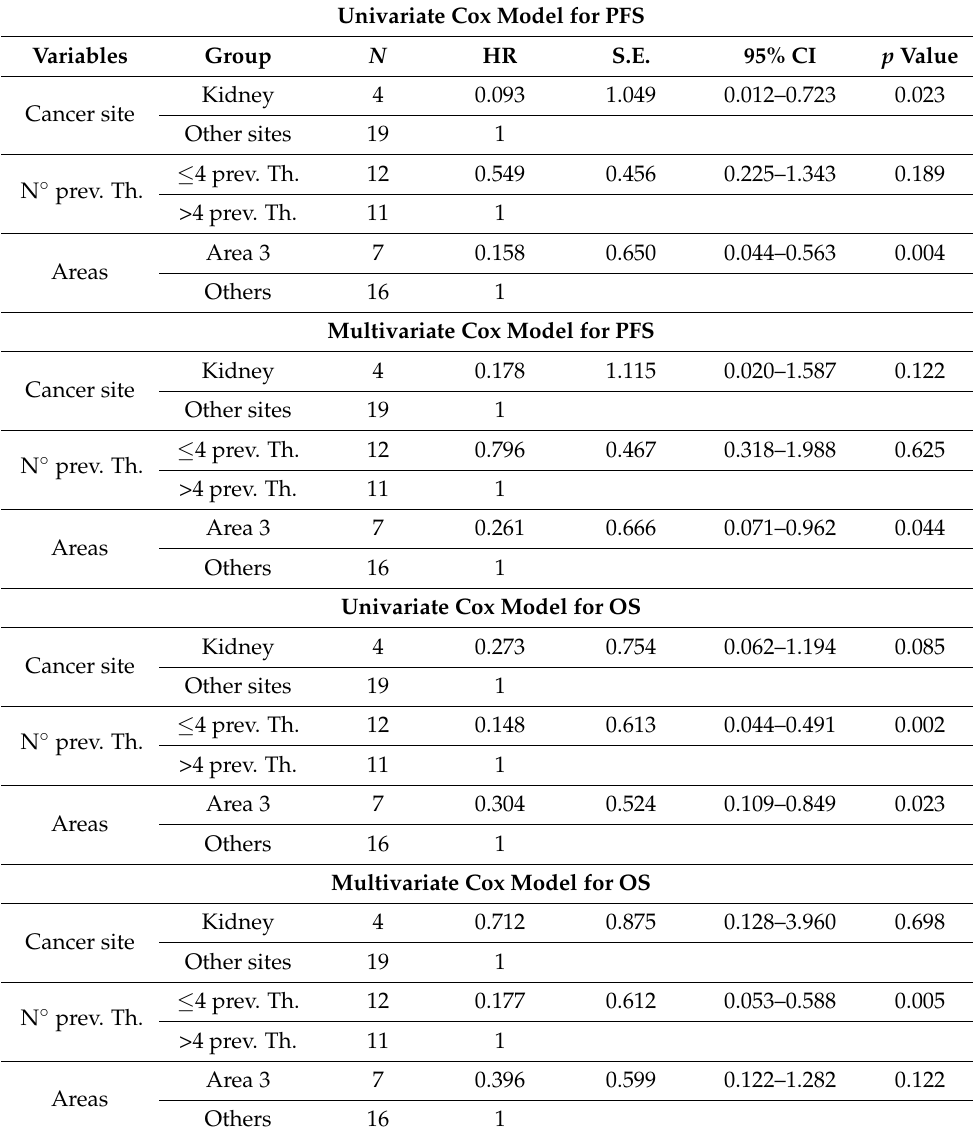
Table 3. Univariate and multivariate Cox analysis. N = number of patients; HR = hazard ratio; S.E. = standard error; CI = confidence interval; N. previous Th. = number of previous medical